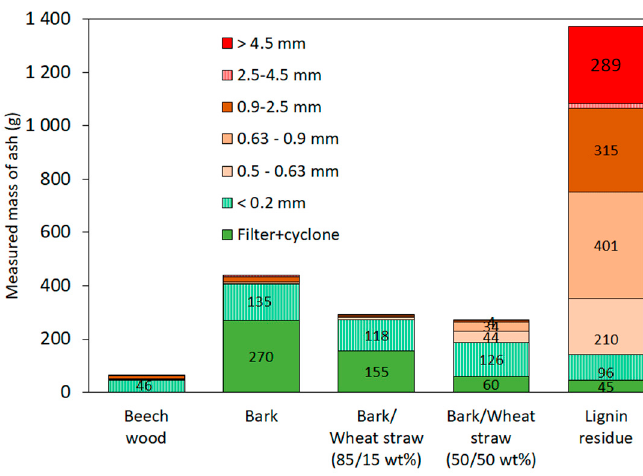
Figure 8. Mass of ash as a function of residue particle class for each feedstock after combustion tests in fluidised bed.